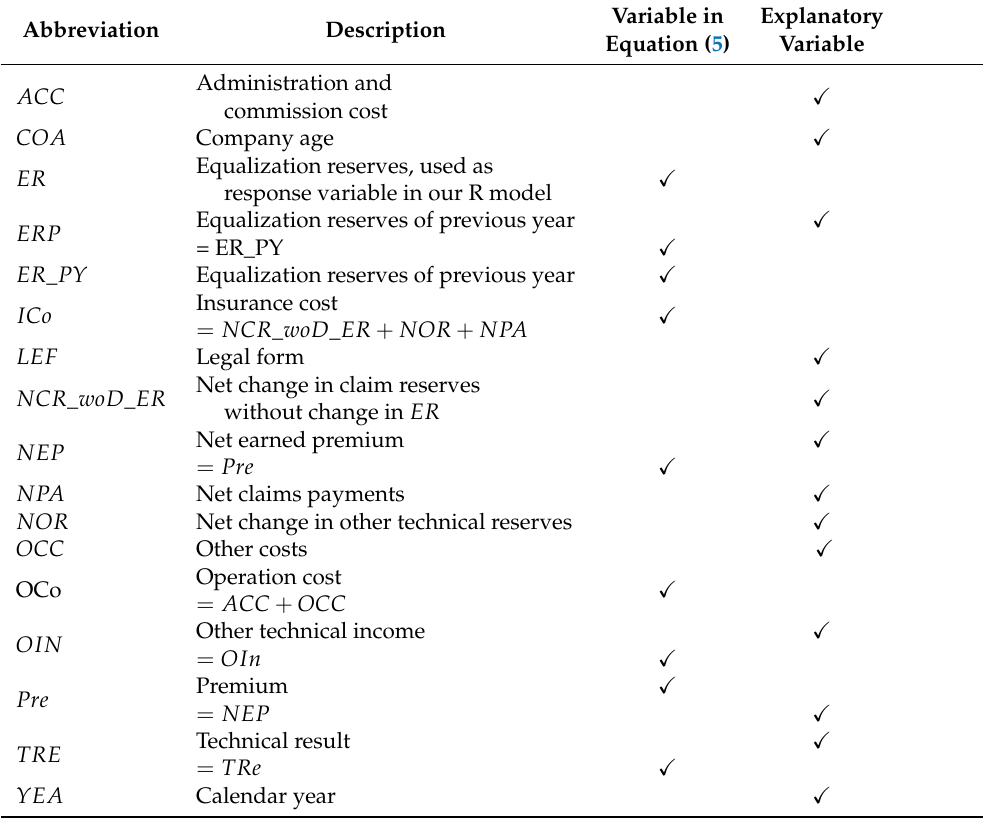
Table 4. Description of variables in alphabetical